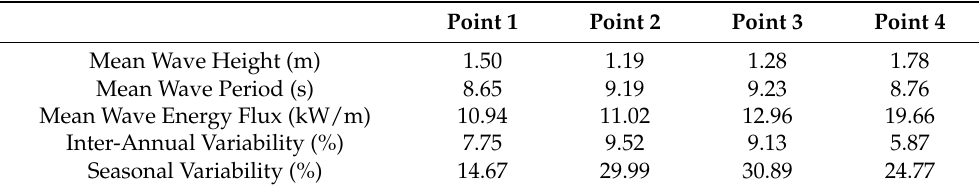
Table 3. Wave climate and wave energy parameters for each point.